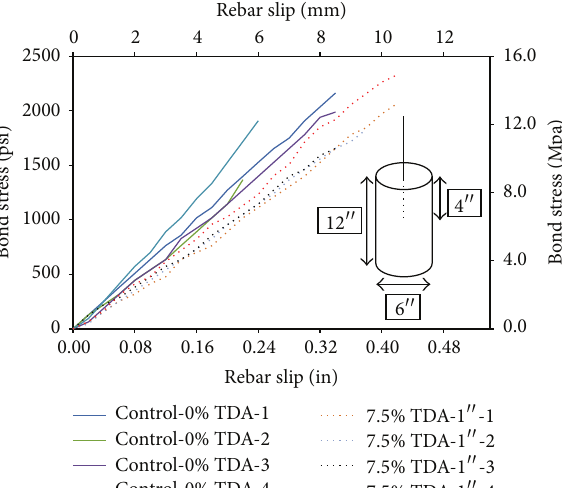
Figure 12: Comparison of bond stress against rebar slip for Control- 0% TDA and 7.5% TDA-1 󸀠󸀠 at 28